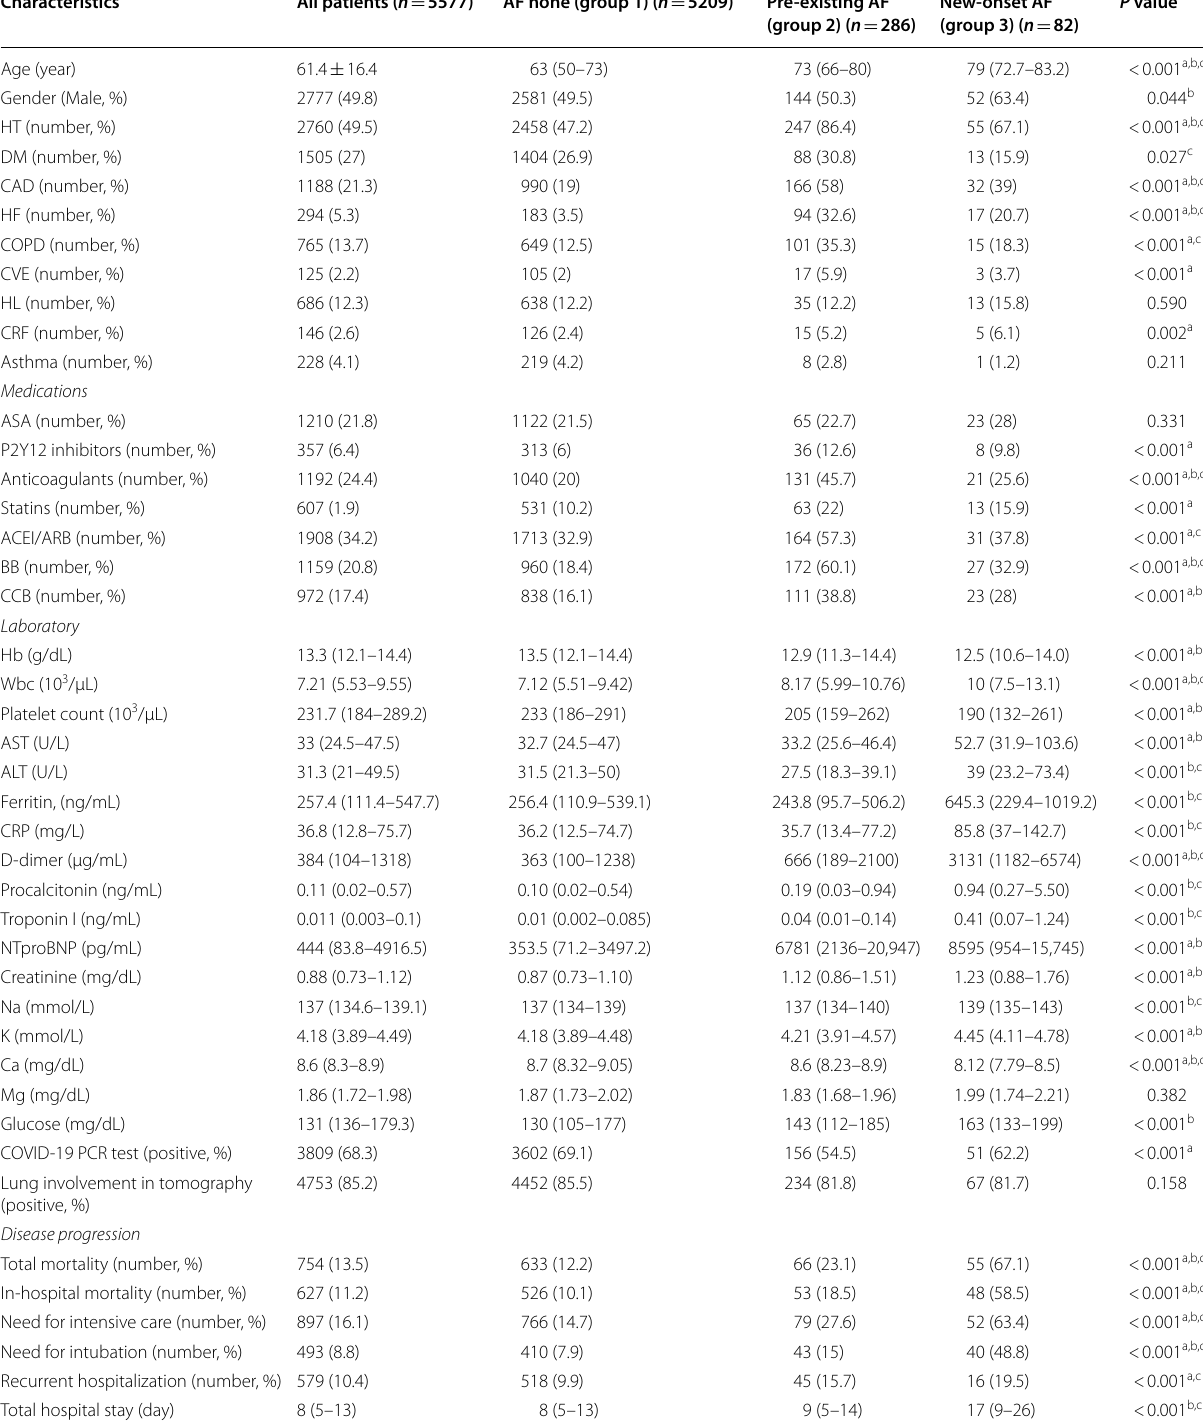
Table 1 Baseline characteristics of